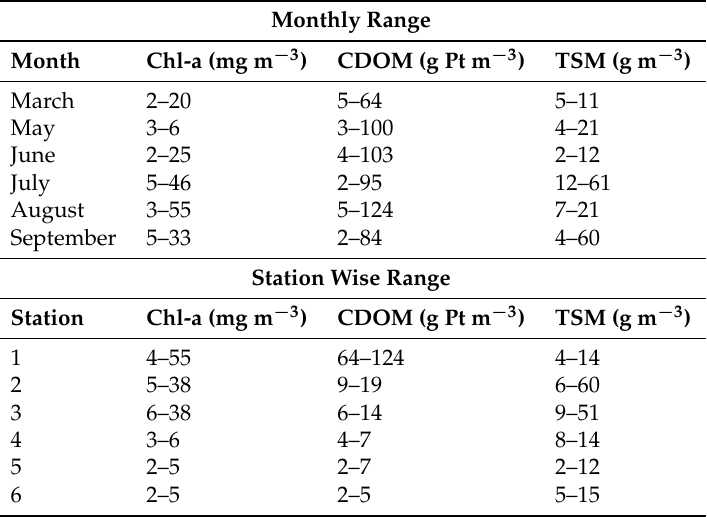
Table 3. Summary of the range of the in situ measured water quality parameters in 2017. See also Figure 6 for further representation of the variablility of the water quality parameters for every station.